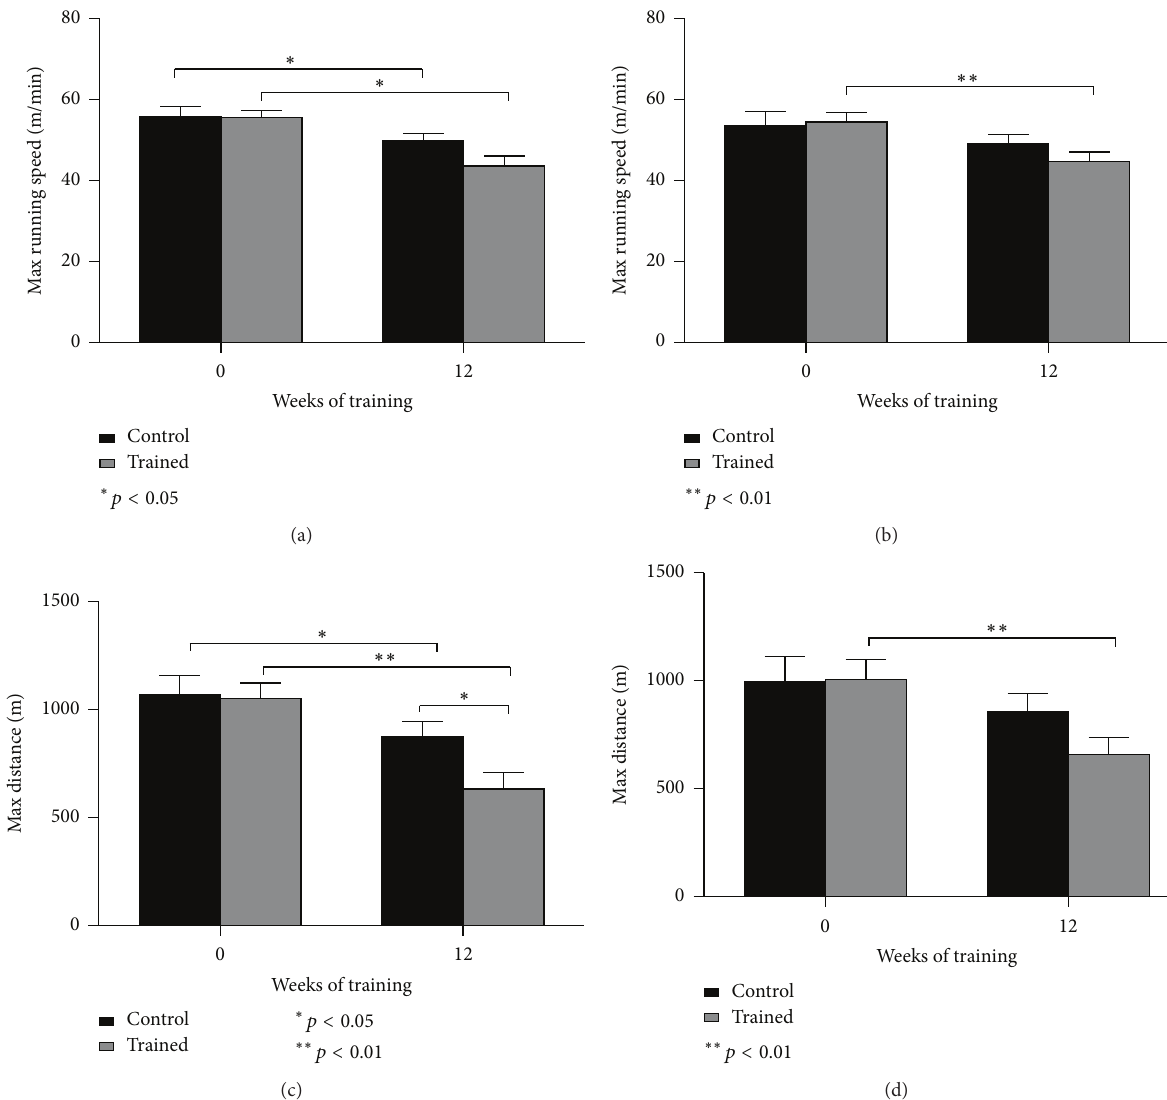
Figure 5: Muscular performance data: speed and distance obtained during a submaximal incremental running test, respectively, in all NOD mice (a, c) and in diabetes-free NOD mice (b, d). Results are shown as means and